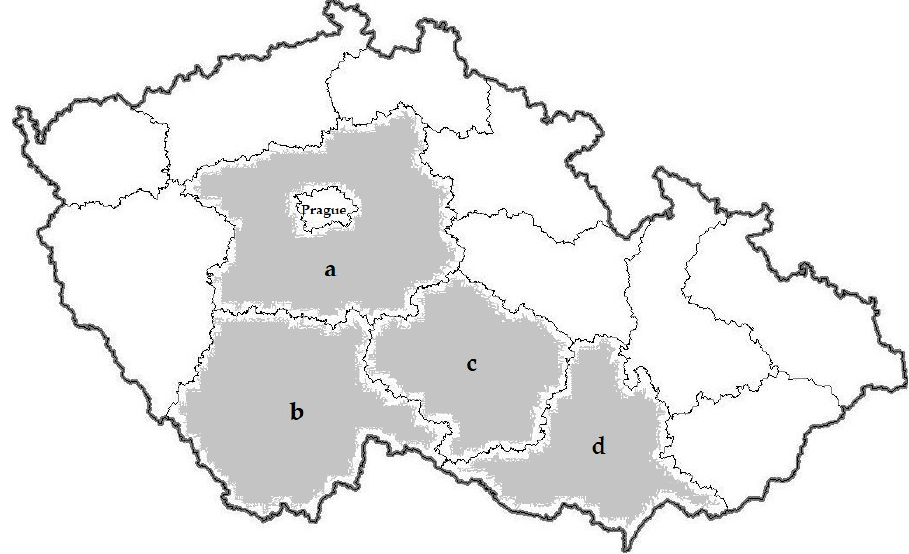
Figure 1. Map of the Czech Republic showing the Regions from where the harvester data originated. These regions are marked in gray: ( a ) Central Bohemia Region; ( b ) South Bohemia Region; ( c ) Vysoˇcina Region; ( d ) South Moravia Region.